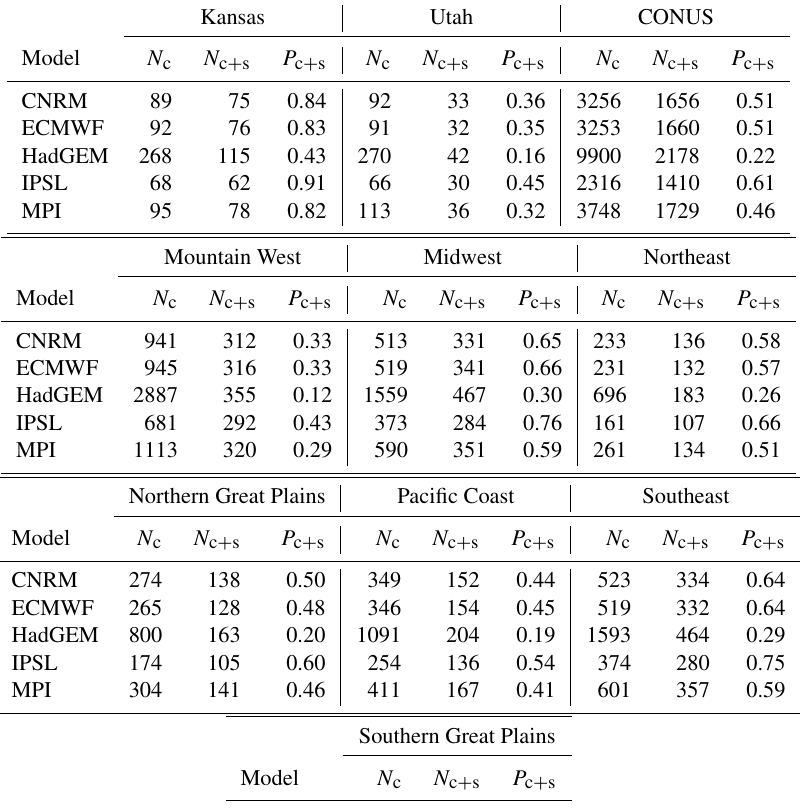
Table A1. Number of model grid cells in each study region ( N c ), the number of model grid cells with at least one high-quality GHCN station ( N c + s ), and the proportion of model grid cells with at least one high-quality GHCN station ( P c + s